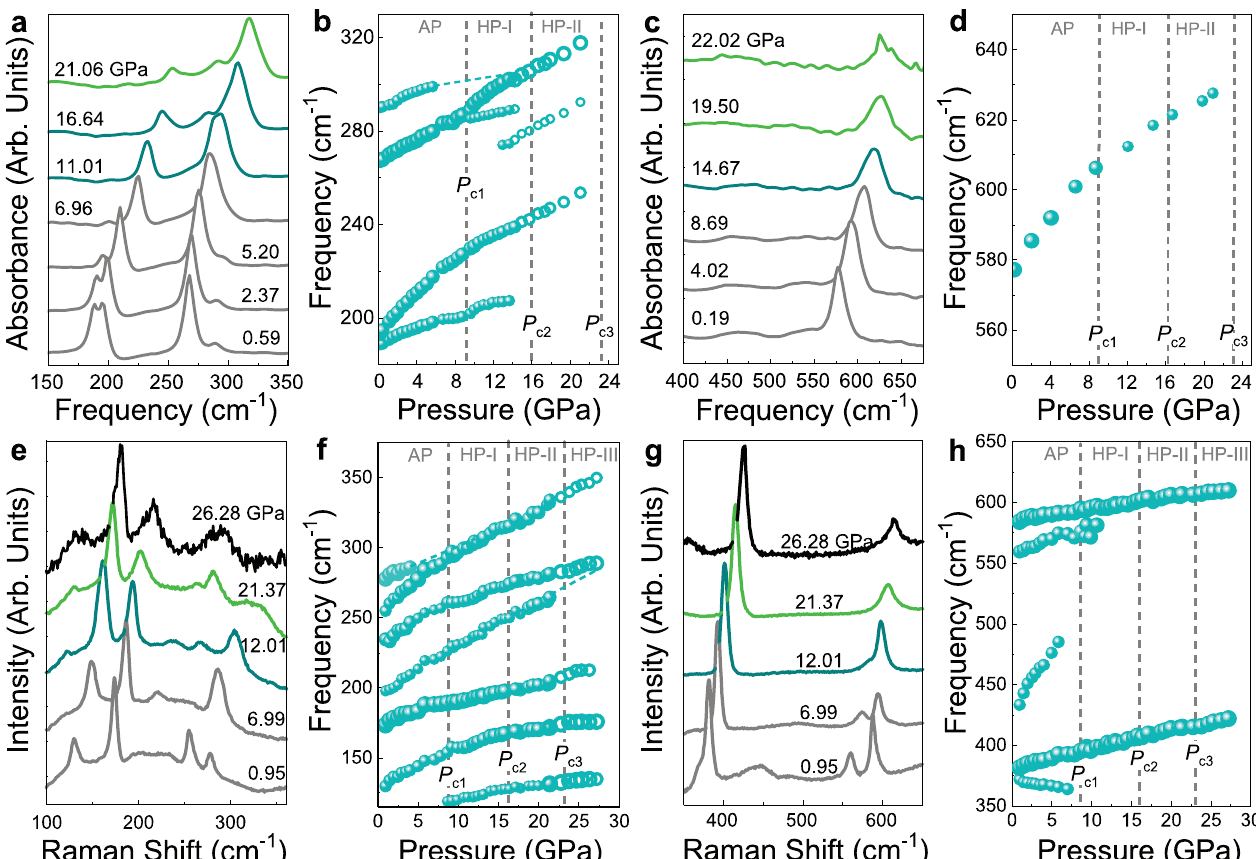
Fig. 1 Vibrational properties of NiPS 3 under compression. a – d Close-up view of the infrared absorption and frequency vs. pressure plots. e – h Close-up view of the Raman scattering response and frequency vs. pressure plots. Spectra for the ambient pressure (AP) phase are shown in gray; those for the high-pressure phases (HP-I, HP-II, and HP-III) are shown in teal, green, and black, respectively. Closed and open circles represent two independent runs. Note that infrared spectra in the HP-III phase do not appear in our measurements because the phonons are screened by the metallic response. The critical pressures ( P C ’ s) separate the high-pressure phases and are indicated with dashed vertical gray